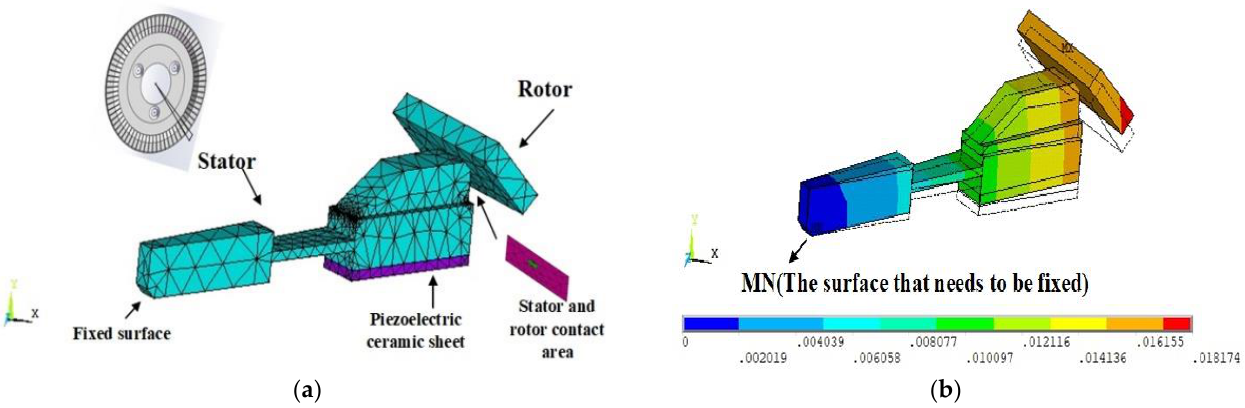
Figure 6. Schematic diagram of contact deformation of stator and rotor. ( a ) Stator and rotor contact modeling. ( b ) Stator and rotor contact simulation.